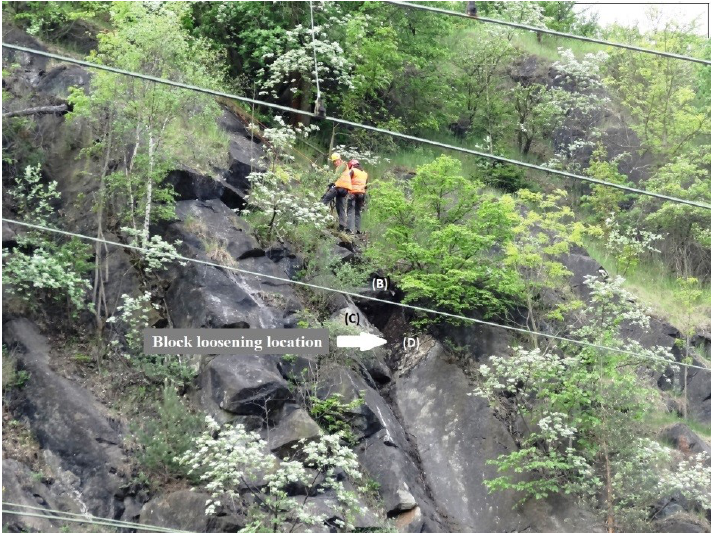
Figure 4. The location of a loosening of the fallen rock block.